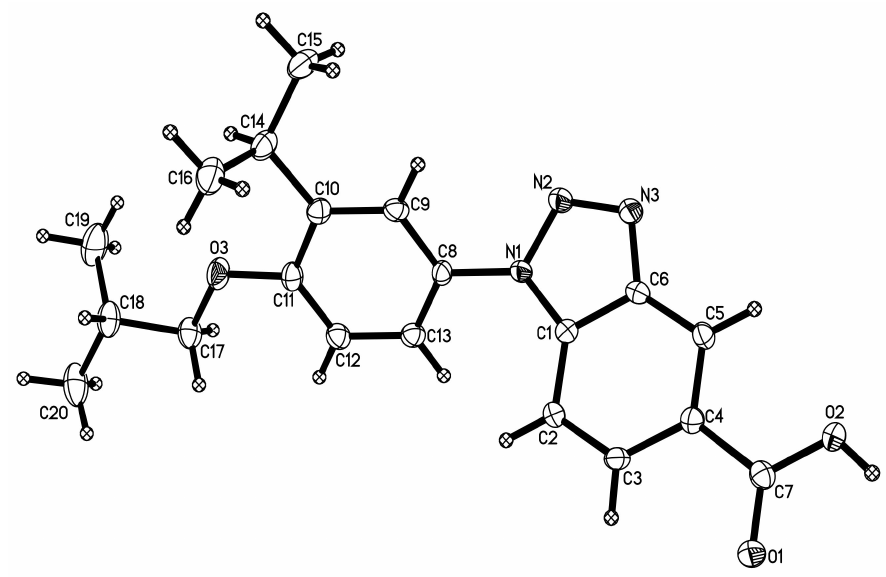
Figure 5. X-ray crystal structure of 31